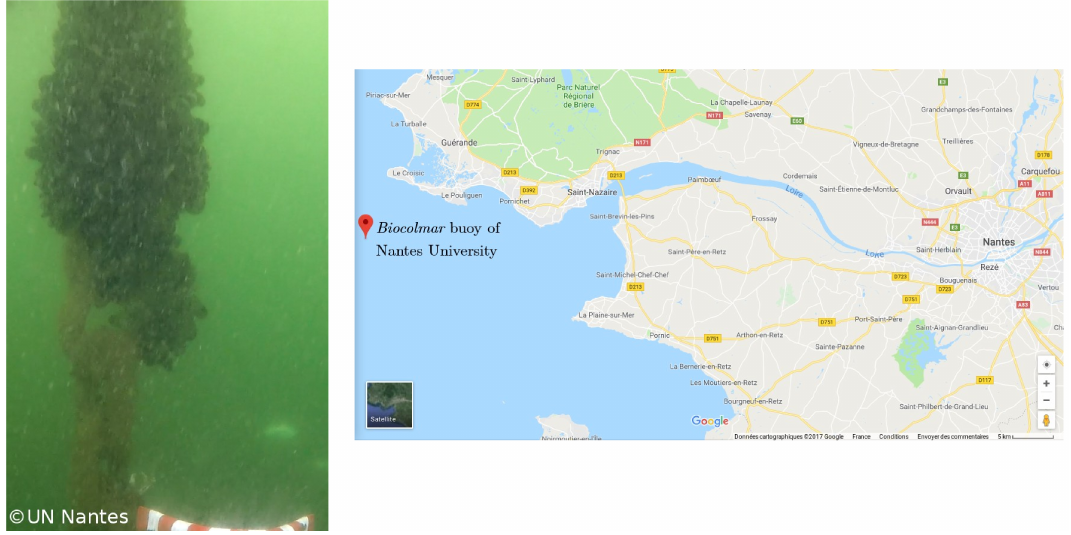
Figure 1. Colonisation of mussels on the mooring chain of the Biocolmar buoy of Nantes